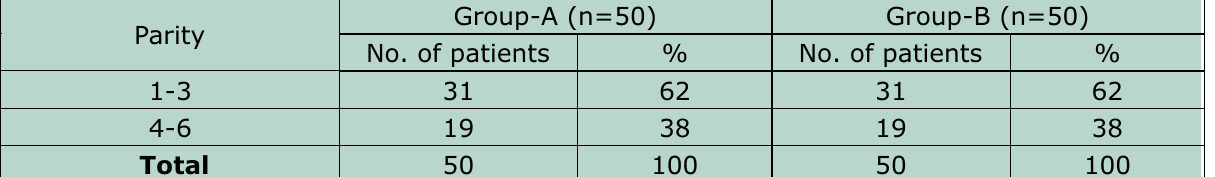
Table-II: C  omparison between two groups regarding parity.